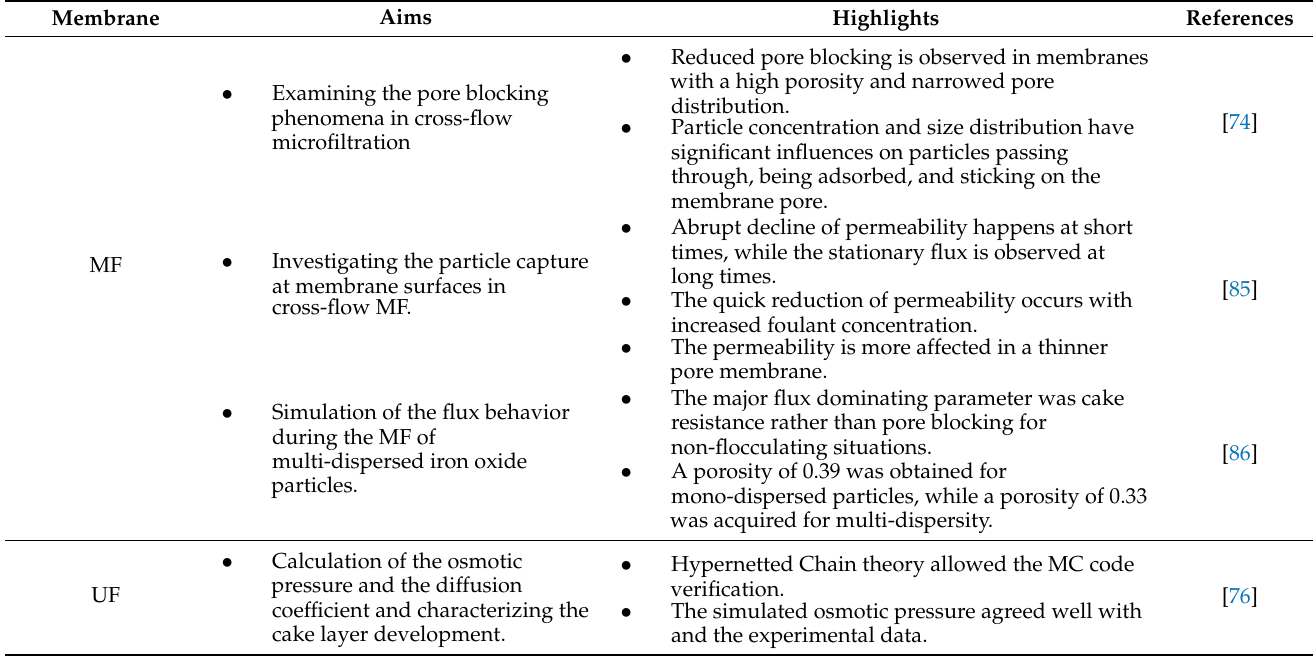
Table 2. Application of MC method for fouling simulation in different membrane systems from the